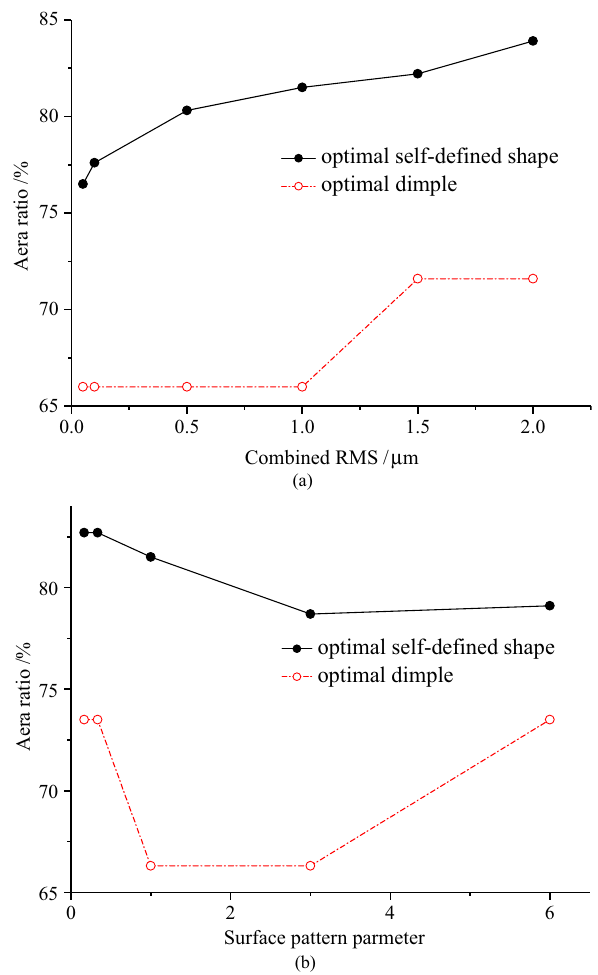
Figure 5. ( a ) Variation of the optimal area ratio with combined RMS; ( b ) variation of the optimal area ratio with surface pattern